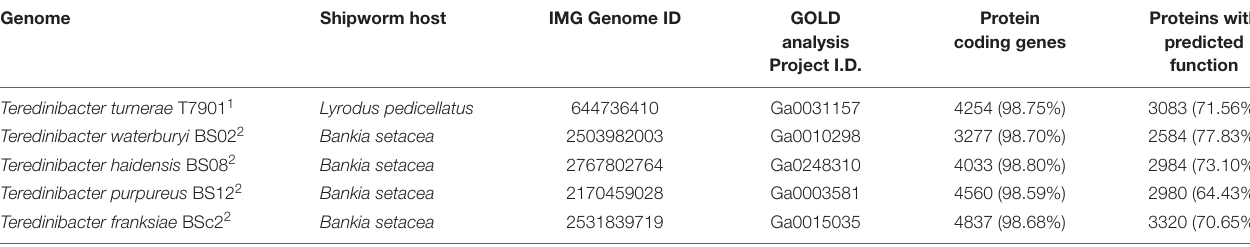
TABLE 1 | Summary of shipworm symbiont bacterial genomes acquired from JGI